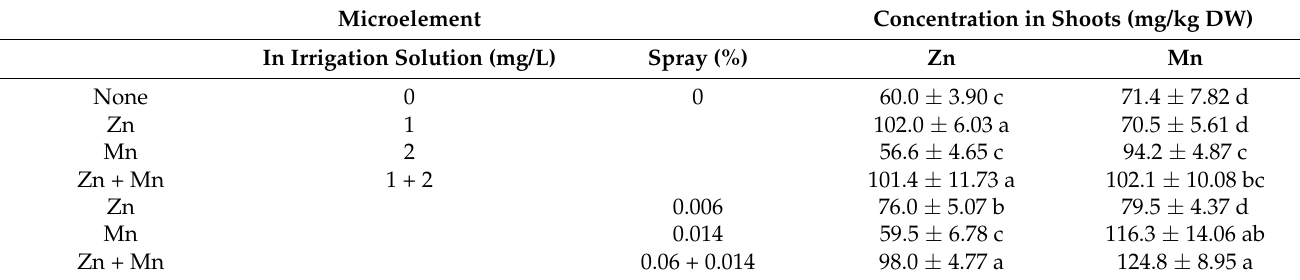
Values for each Mg treatment and each microelement treatment that are followed by a different letter are significantly different according to one-way ANOVA with Tukey’s HSD